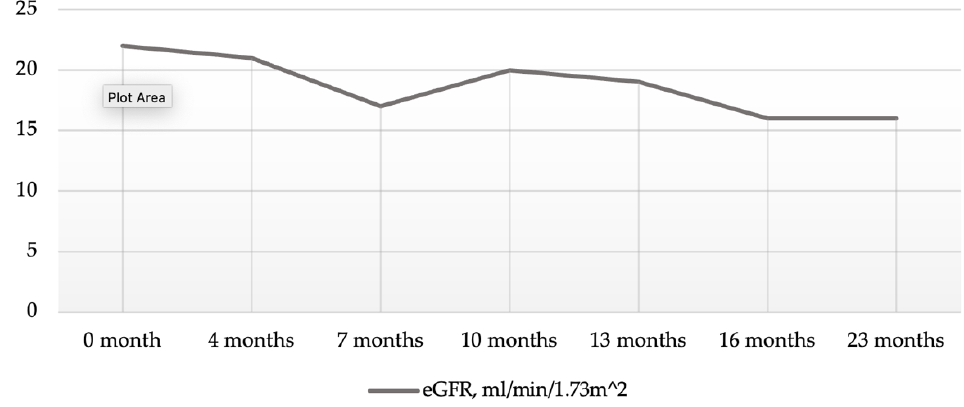
Figure 1. Course of renal function before transferring to a tertiary care nephrologist. Note: Kidney function was evaluated as eGFR (grey line). The 0 month marker represents the beginning of regular visits to a nephrologist in May 2019 (SCr —295 μmol/L) , whereas 22 months represents the last visit before transferring to tertiary care (April 2021) (SCr —395 μmol/L) .